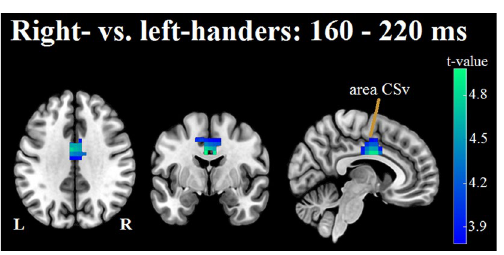
Figure 6. Visualisation of results from source localization analysis comparing the differences in estimated source activity between conditions in right- versus left-handers, during the early (160–220 ms) window. Results revealed that the estimated source activity exhibited in the coherent minus the incoherent condition differed between left- and right-handers primarily in area